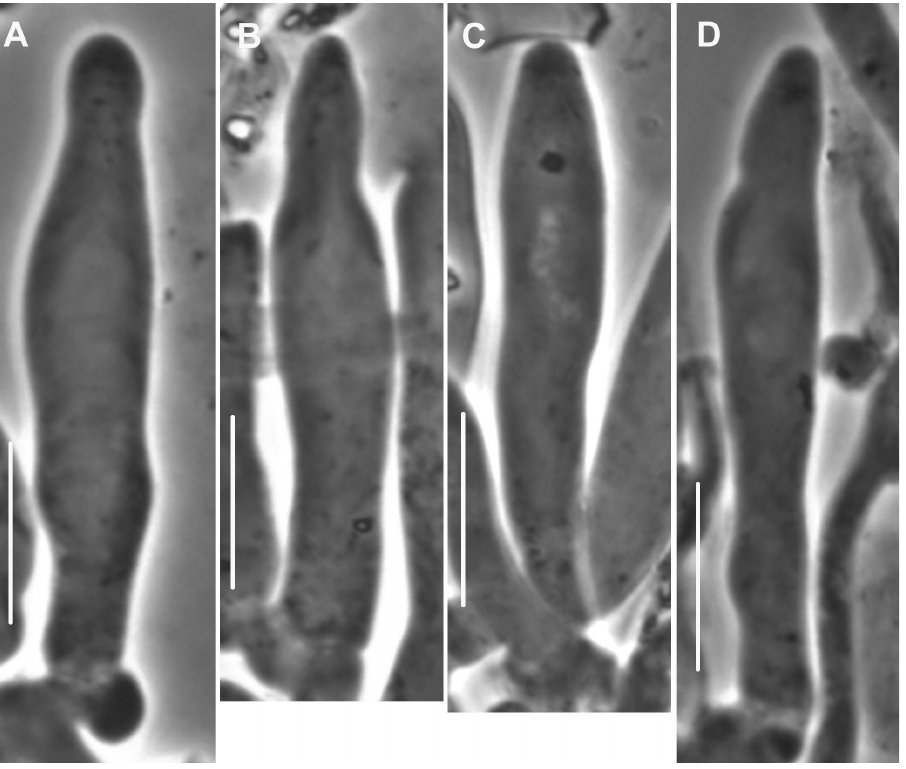
Figure 73. Mycetinis scorodonius . Pleurocystidia. Standard bars = 10 µm. TFB 7261 (TENN-F-53568). glabrous to sometimes delicately pruinose at apex only, pallid to pale brown at apex, “tilleul buff” 7B2, drying to “cinnamon buff” 6B4, brownish orange 6C4, downward off-white becoming brown, “sayal brown” 6C5, dark reddish brown 7F8, mahogany, “Verona brown” 6E5, or orange-brown, “Brussels brown”6E6, “Mikado brown” 7C6, “mummy brown” 6F8 towards base, with fine rusty tomentum at base. Context thin, white to pale brown. Rhizomorphs not reported. Odor weak to strong of garlic, rarely lacking; taste usually